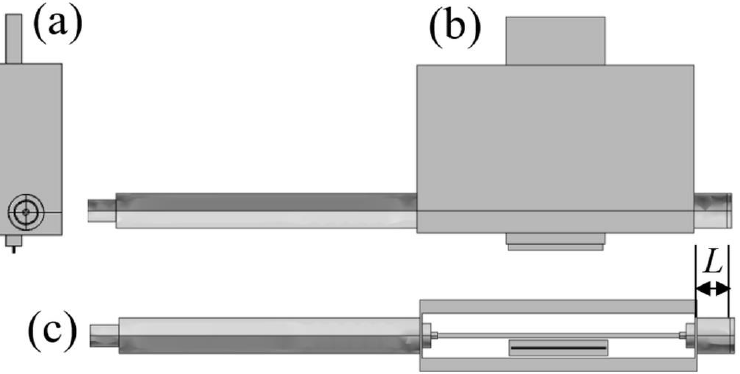
Figure 3. Three views of the MPSS model used for calculations, ( a ) left side view, ( b ) front view, and ( c ) bottom view. Position of the plunger is shown in ( c ).